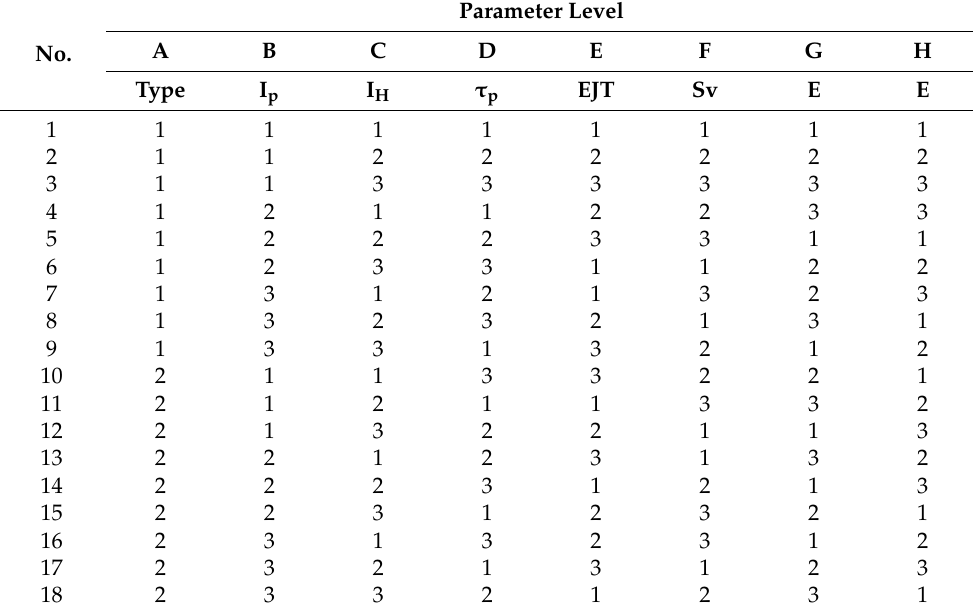
Table 6. Experimental layout in a L 18 (2 1 × 3 7 ) orthogonal